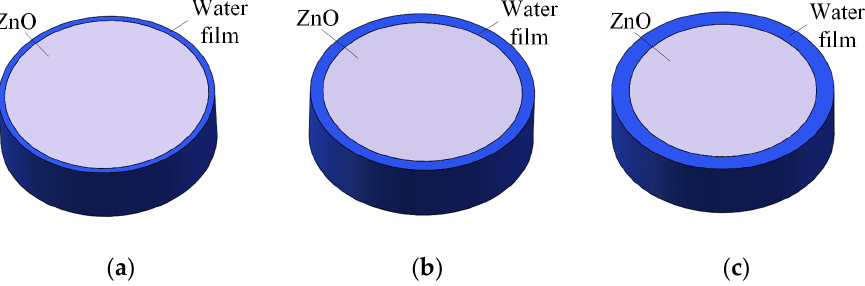
Figure 12. Water film model. ( a ) slight wetness; ( b ) moderate wetness; and ( c ) severe wetness. The arrester is simulated under 289 kVrms conditions, and the magnetic field distribu- tion is shown in Figure 13.